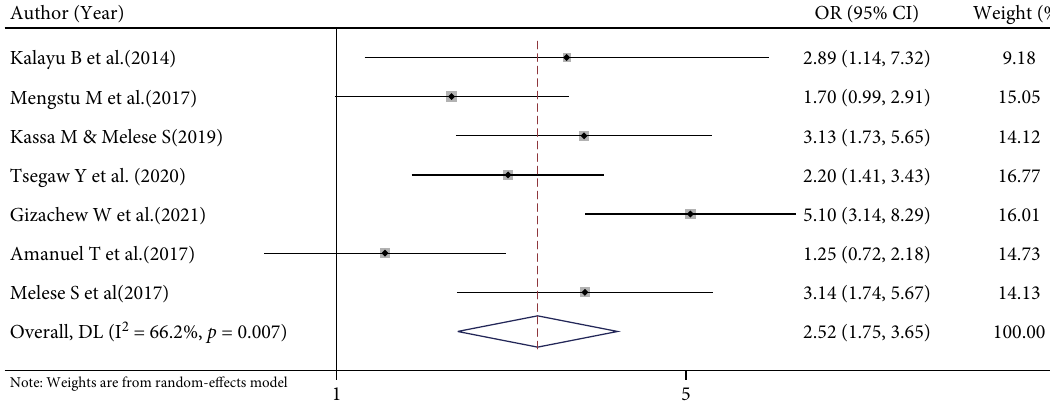
Figure 5: Forest plot for the pooled estimate of the e ff ect of side e ff ects on Implanon discontinuation, a systematic review and meta-analysis, Ethiopia,